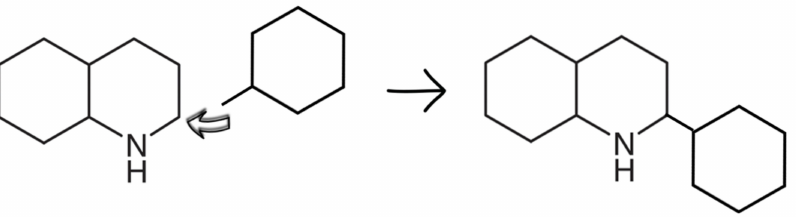
Figure 5. Calculation of enthalpy of formation, ∆ f H o m (liq), of cyclohexyl-substituted decahydroquino- line using the H → cyclohexyl increment. The H → cyclohexyl = − 117.1 ± 1.7 kJ · mol − 1 increment was calculated as difference ∆ f H o m (liq, bicyclohexyl) − ∆ f H o m (liq, cyclohexane), numerical data are given in Table